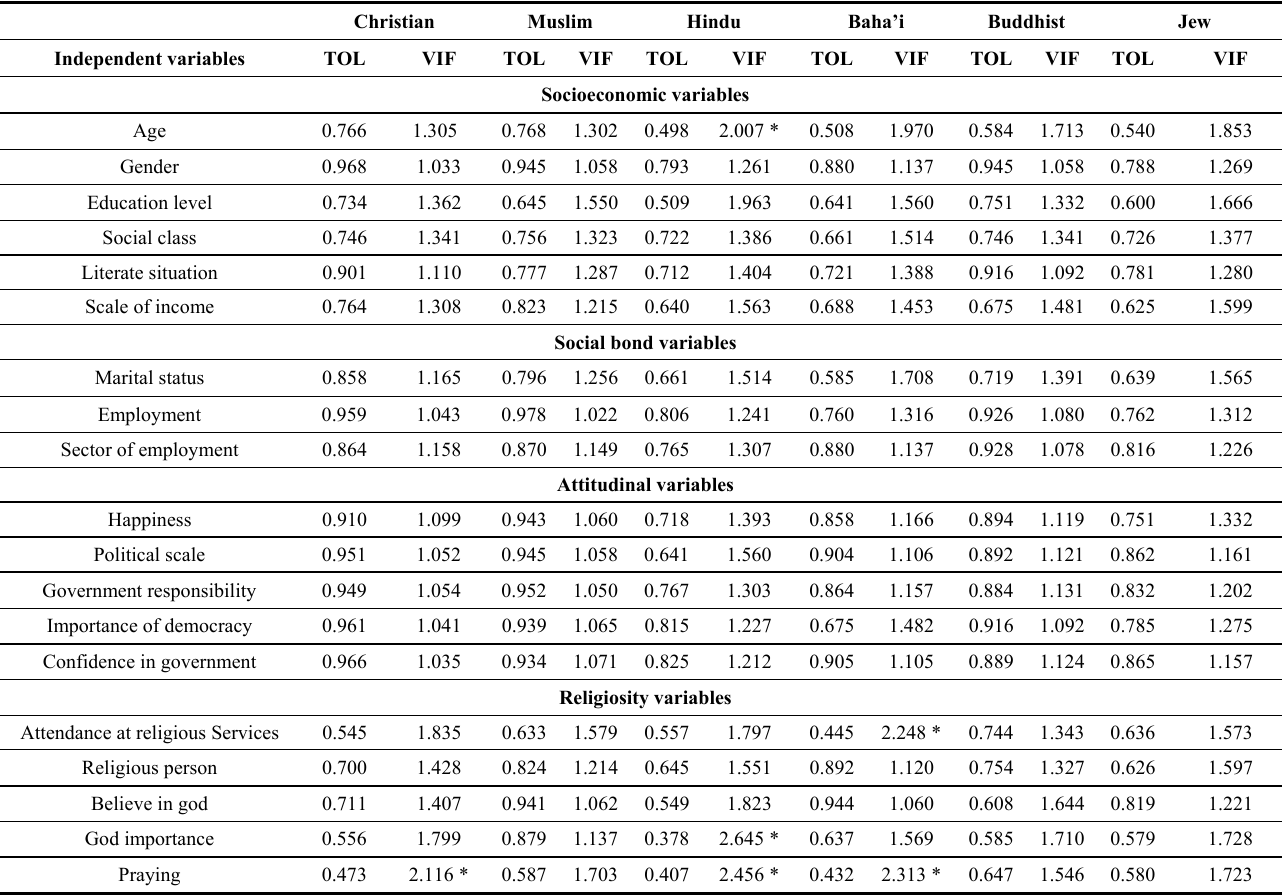
Table 2. The multicollinearity diagnosis indexes for independent